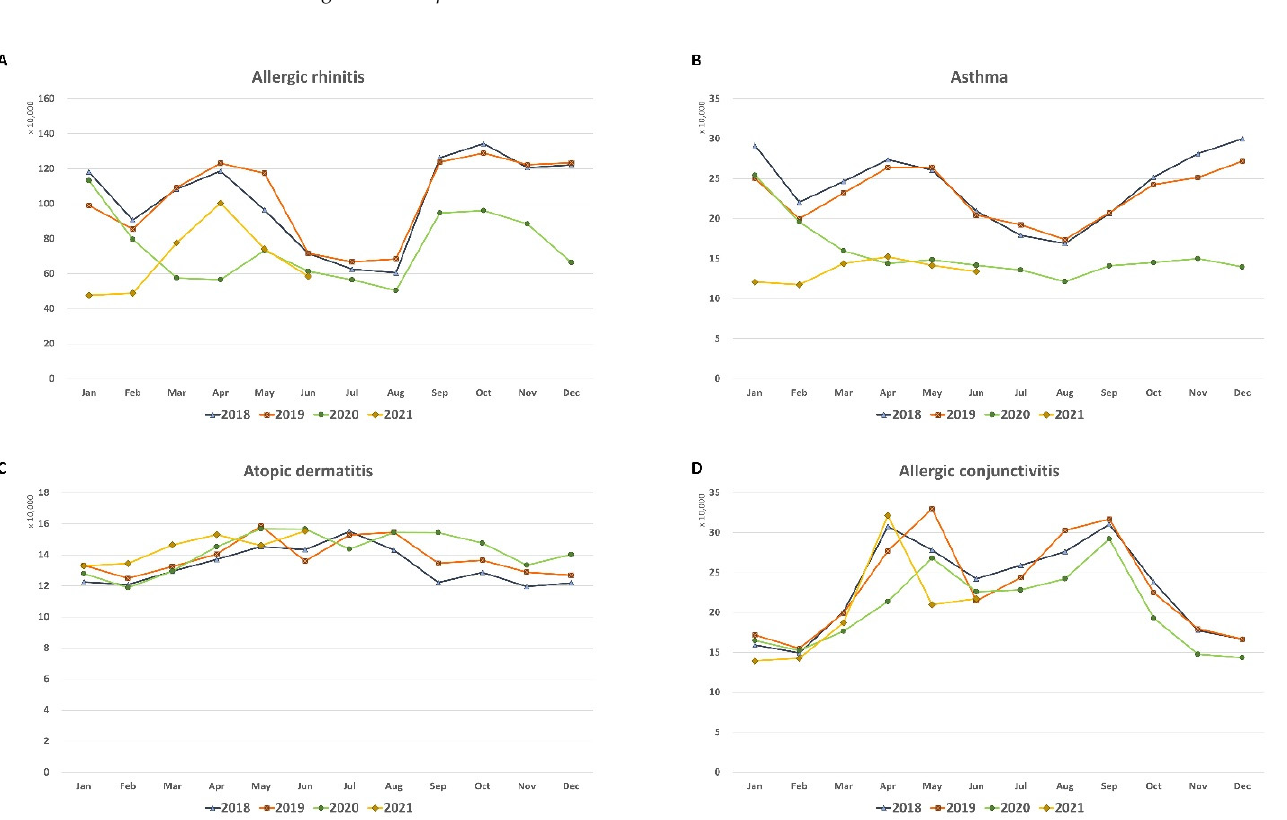
Figure 1. Monthly numbers of medical visits for allergic diseases (January 2018–June 2021): ( A ) Allergic rhinitis; ( B ) asthma; ( C ) atopic dermatitis; ( D ) allergic